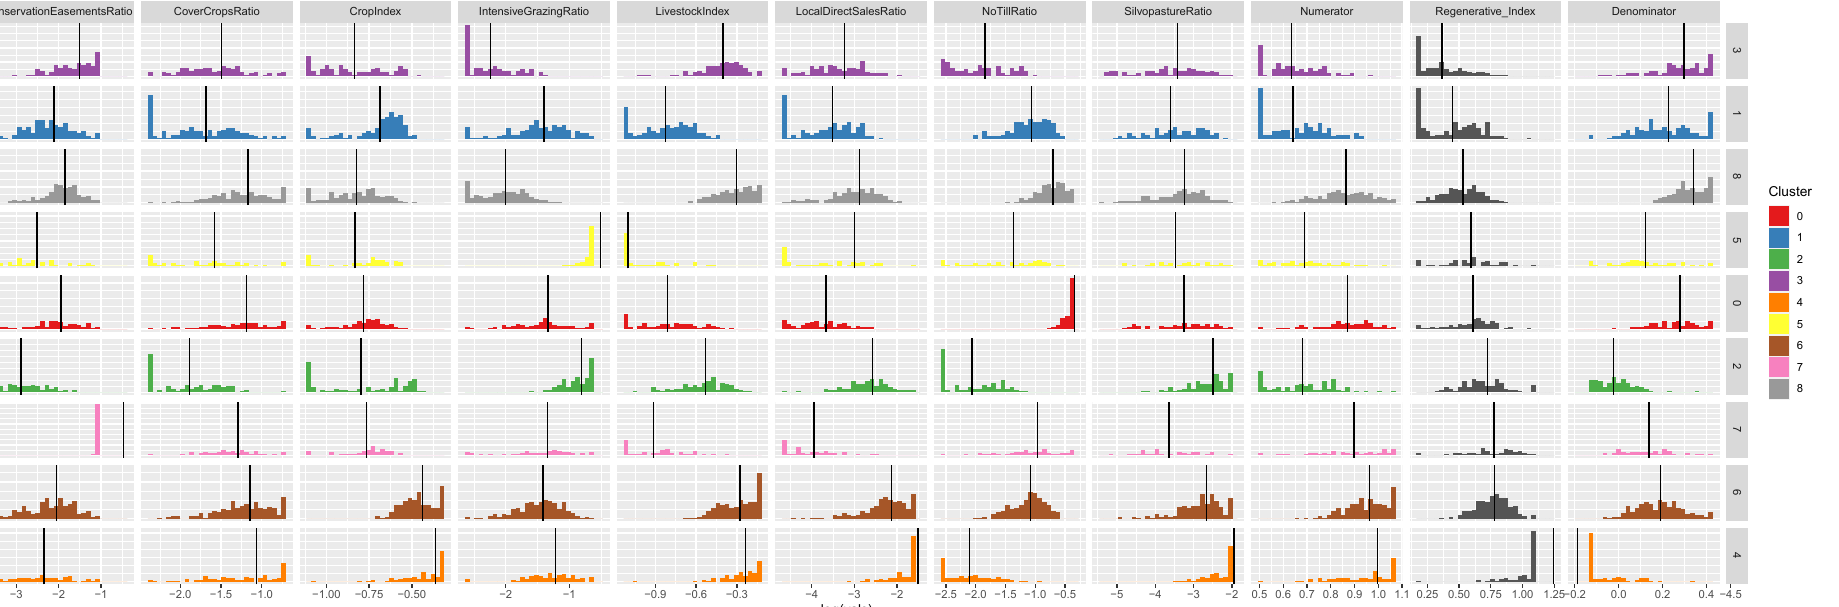
Figure 6. Histograms of index numerator variables broken out by county cluster membership. Each cluster’s counties have a row; each variable has a column. Although clusters are not calculated on the overall index, nor on the numerator or denominator, those three derived variables are presented here for reference in the rightmost three columns. Indeed, cluster rows are sorted by their overall regenerative index. A vertical black line indicates the mean value for the variables in its cluster. Note that, for efficient use of space on the visualization, the 7% highest and 7% lowest values for a given variable (regardless of which cluster they may be contained in) are not shown at their correct x -values; they are instead stacked in the histogram in the bins where the 7th and 93rd percentiles would be displayed, respectively. Vertical lines for mean values, however, are not constrained in this way but appear at their proper values, which on occasion leads to some of them seeming to appear outside of the